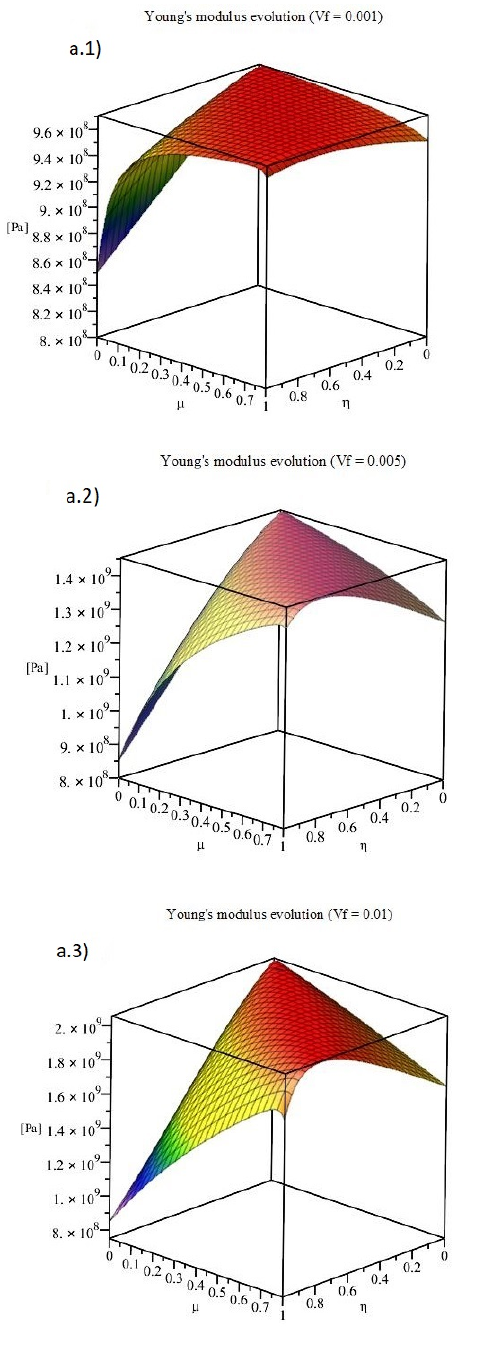
Figure 5. Mechanical properties evolution for partially agglomerated states. ( a.1 ) Young’s modulus for Vf = 0.001, ( b.1 ) Poisson’s ratio for Vf = 0.001, ( a.2 ) Young’s modulus for Vf = 0.005, ( b.2 ) Poisson’s ratio for Vf = 0.005, ( a.3 ) Young’s modulus for Vf = 0.01, ( b.3 ) Poisson’s ratio for Vf = 0.01.